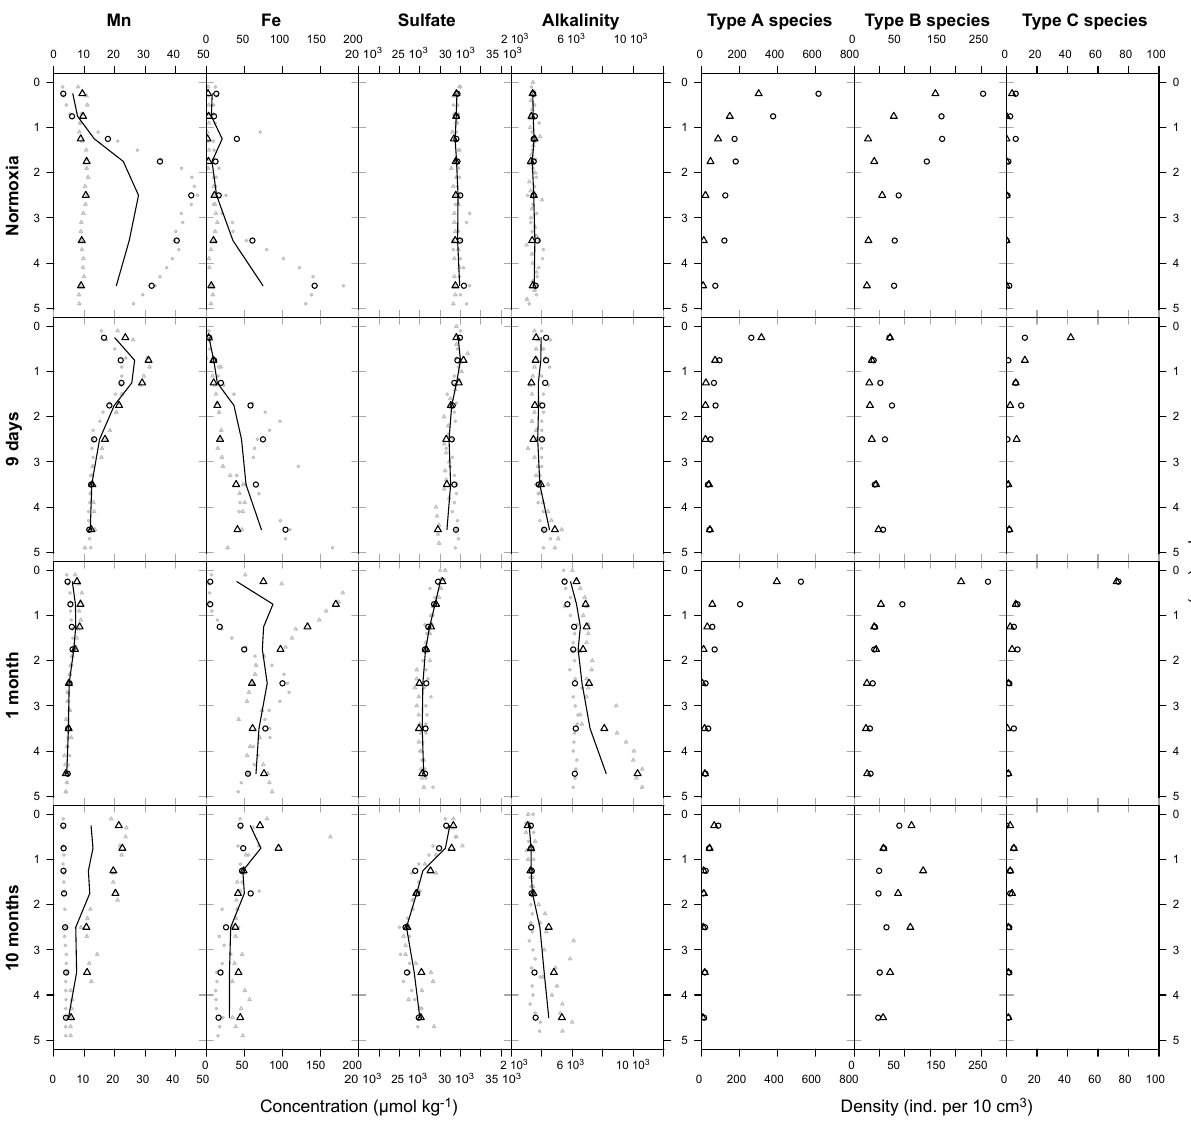
Fig. 5. Vertical profiles of dissolved manganese, iron, sulfates and alkalinity with sediment depth at all sampling points after data presented in Metzger et al. (2013) and vertical profiles of the total densities of the type A, B and C species. The raw geochemistry data are presented as small, grey open circles and triangles for the two replicate probes. Large, black open circle: concentration values averaged for each depth interval (0–0.5cm, ... 4–5cm). Black line: average for both replicates. The foraminiferal densities are presented as open circles and triangles for cores 1 and 2,